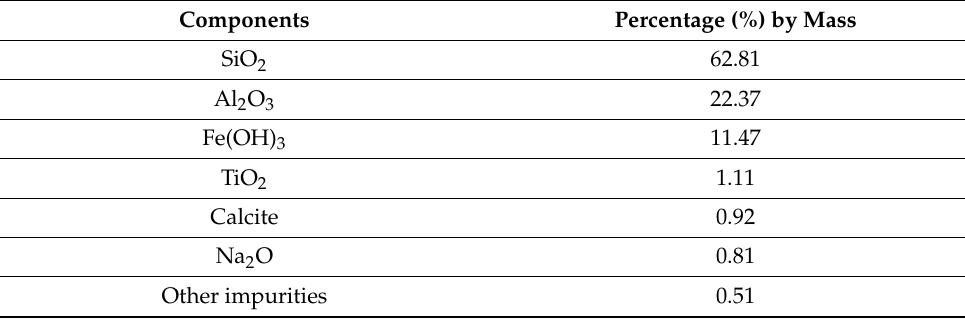
Figure 1. NS micrograph at 50 µm after sieving through a 75 µm sieve. Table 1. Natural soil composition [8].